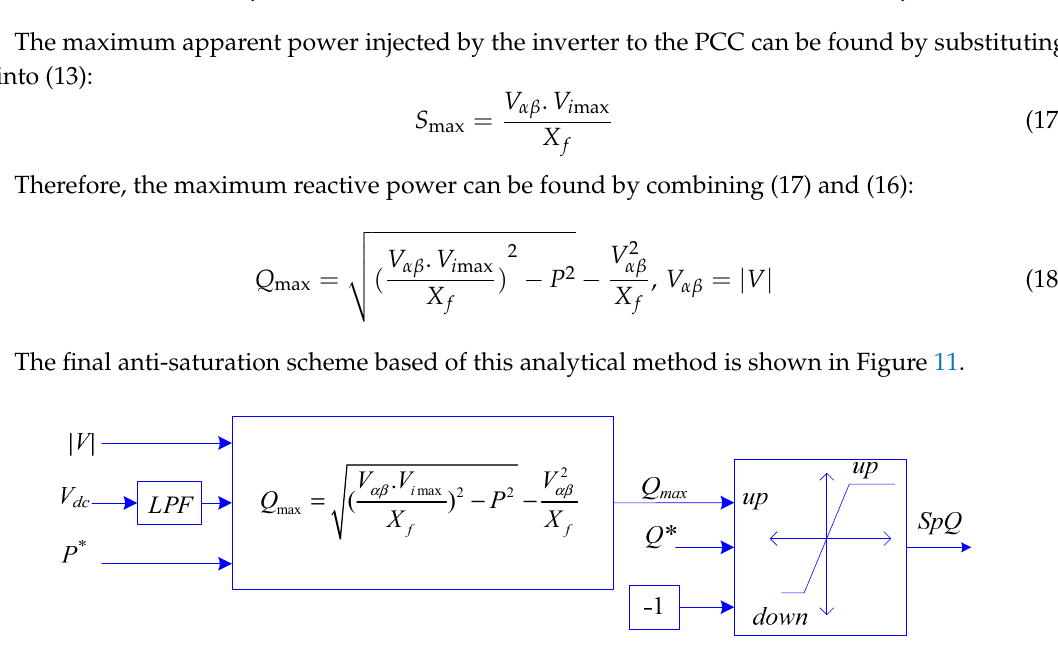
Figure 11. Anti-saturation scheme considering active and reactive power references.